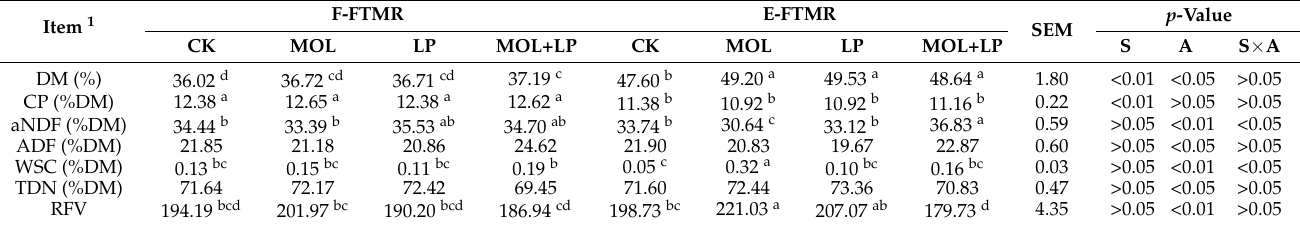
Table 7. The chemical compositions of fresh-alfalfa and ensiled-alfalfa FTMR after 60 d of